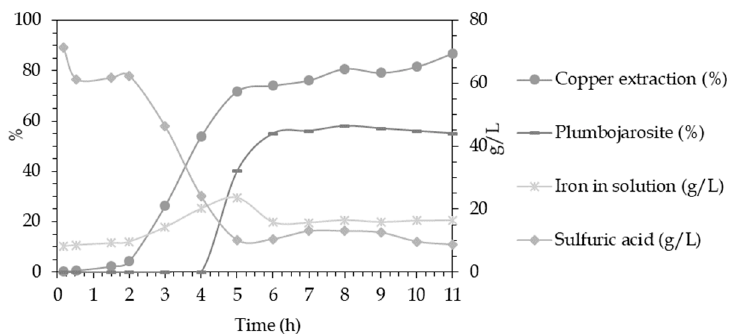
Figure 11. Results of an exploratory test with a low acid concentration in the reaction solution.